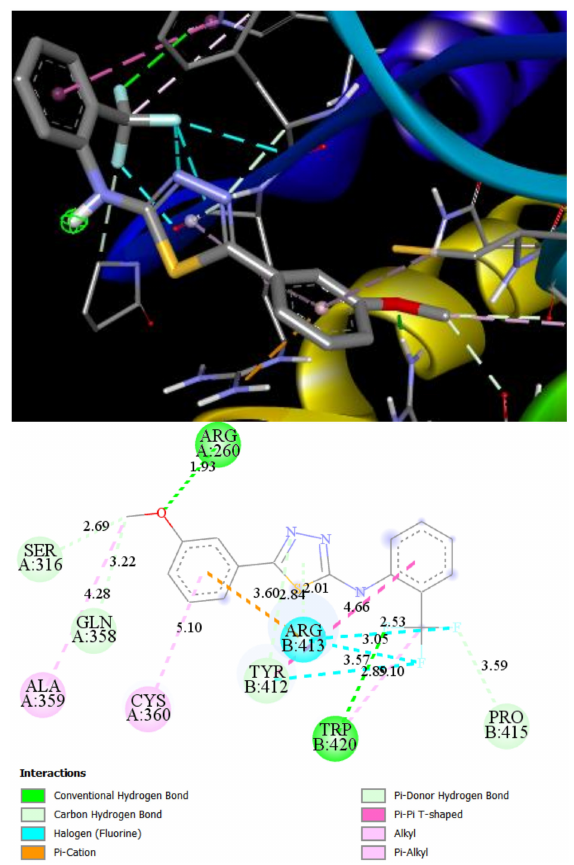
Figure 6. 2D and 3D interaction maps of ST10 with Caspase